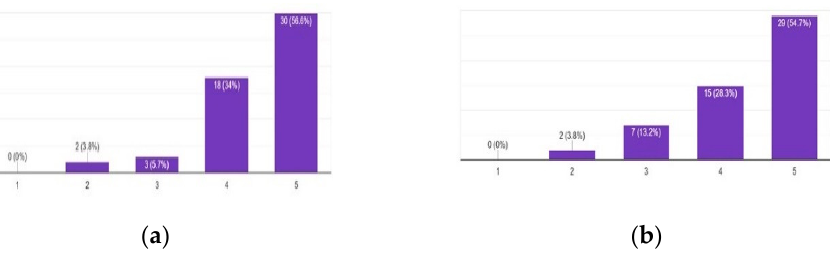
Figure 20. Participants’ opinion: ( a ) the proposed activity helps students understand the significance of the fusion of Informatics, Networking, Robotics and Artificial Intelligence in modern Agriculture; ( b ) the proposed activity adds on the skills needed for students’ future professional career.